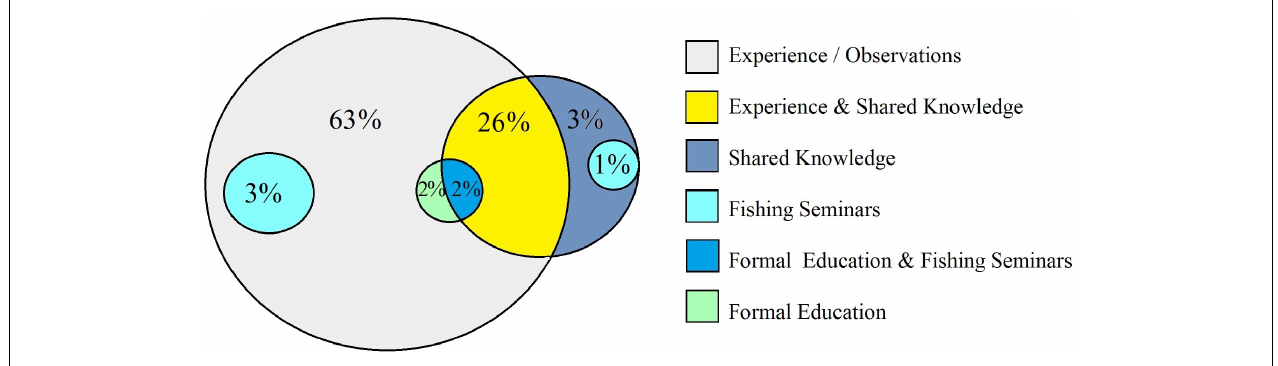
FIGURE 3 | Venn diagram showing the methods of knowledge acquisition on fish ecology/biology by fishers. TABLE 1 | A PERMANOVA table based on Euclidean dissimilarity for LEK data between different groups of fishers in Zanzibar, Tanzania. Source df SS MS Pseudo-F P (perm)